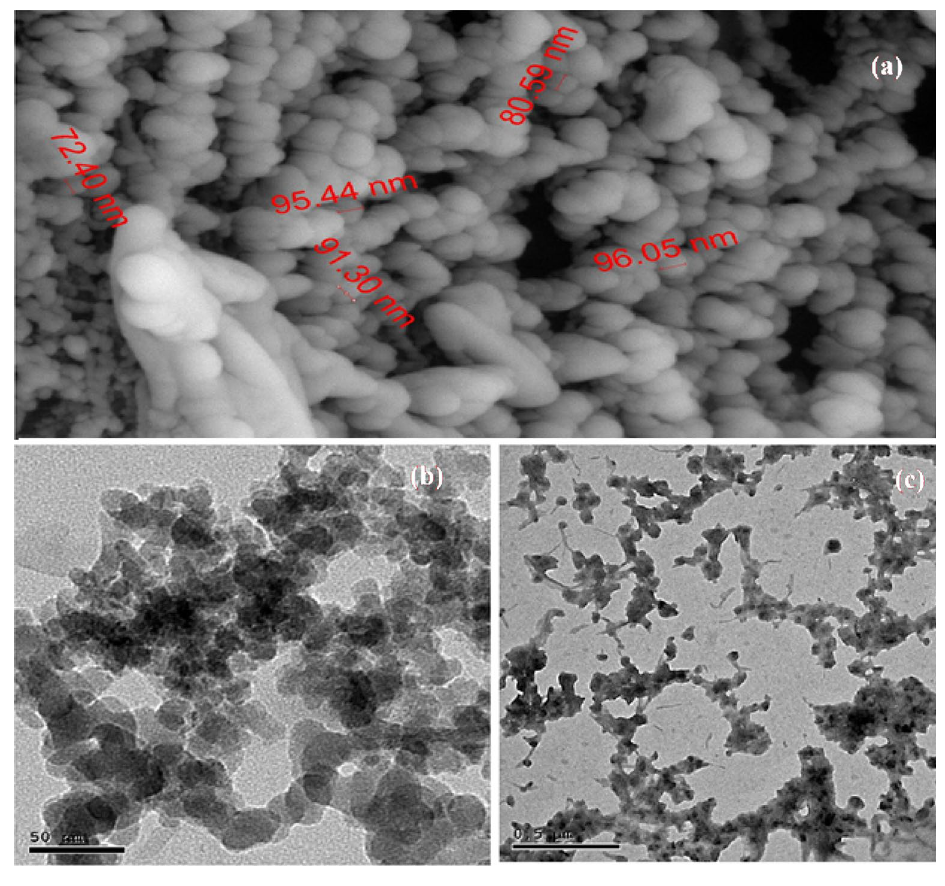
Figure 4. a SEM of C1; b & c TEM of